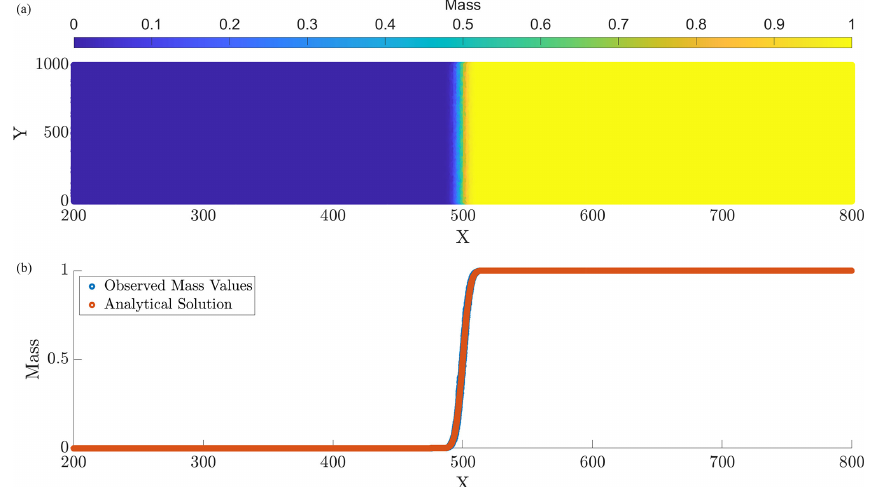
Figure 1. Panel (a) displays the computed particle masses at final simulation time T = 10, and panel (b) provides a computed vs. analytical solution comparison at the corresponding time. The parameters for this run are N = 10 7 , (cid:49)t = 0 . 1, and D = 1.